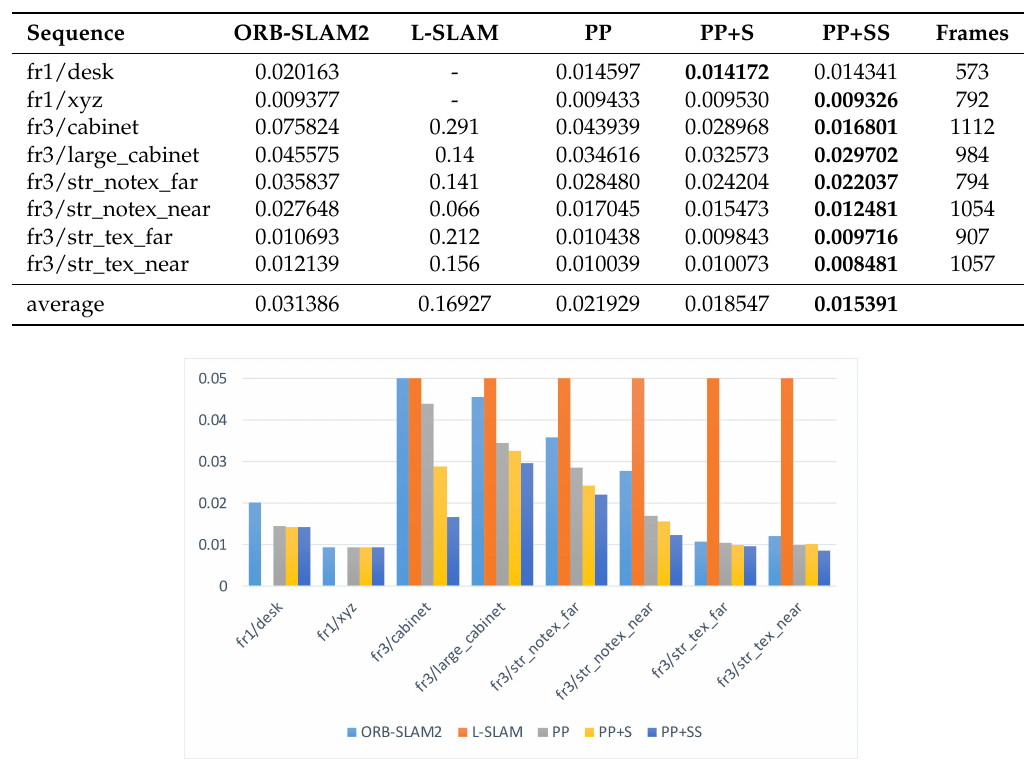
Figure 9. The comparison of the RMSE on TUM RGB-D dataset.